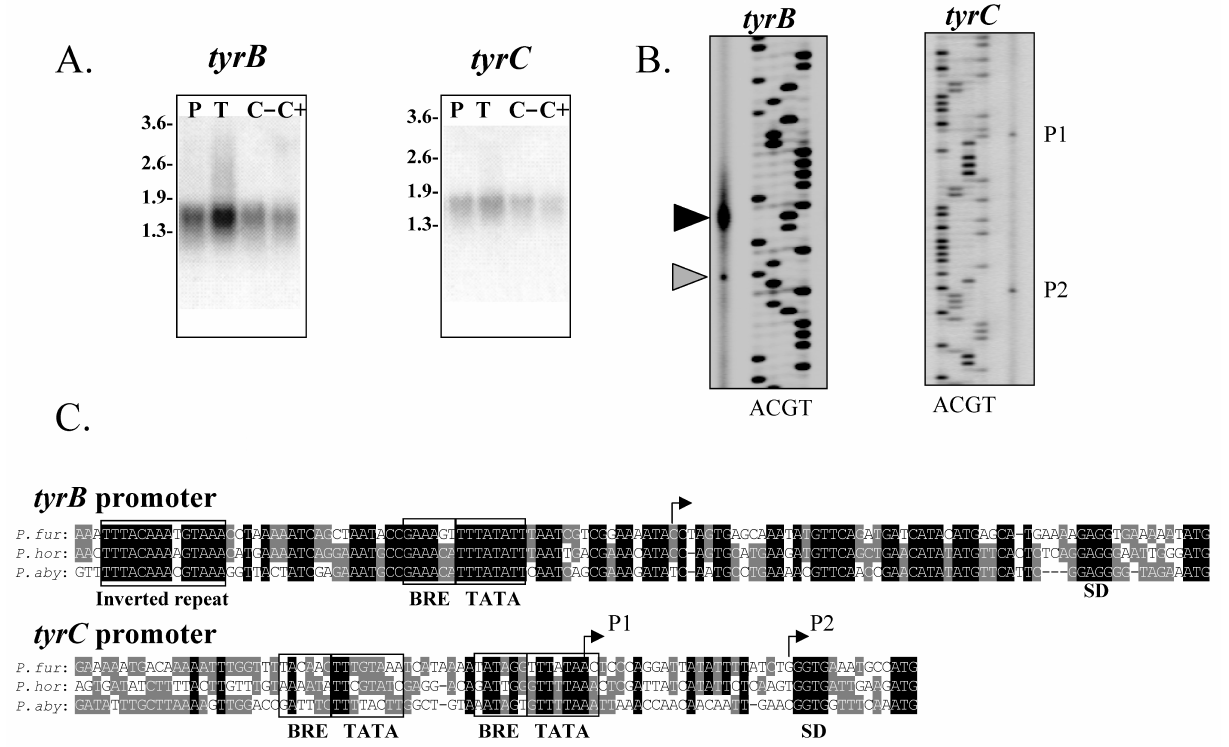
Figure 3. (A) Northern blot analysis of the P. furiosustyrB (AroAT I) and tyrC (AroAT II) transcripts. Pyrococcus furiosus was grown with the